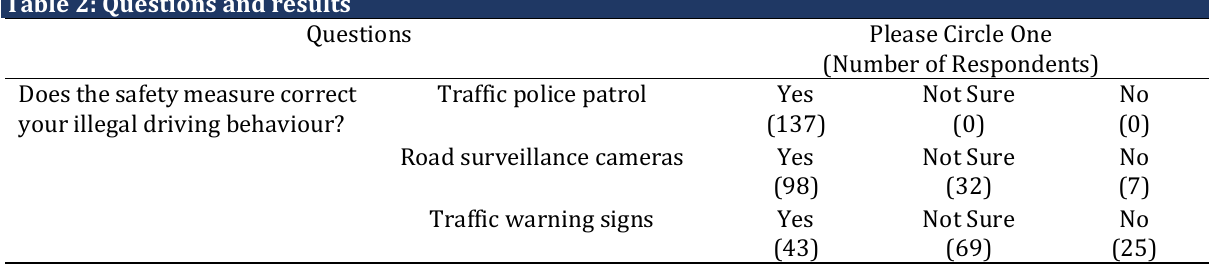
Table 2: Questions and results